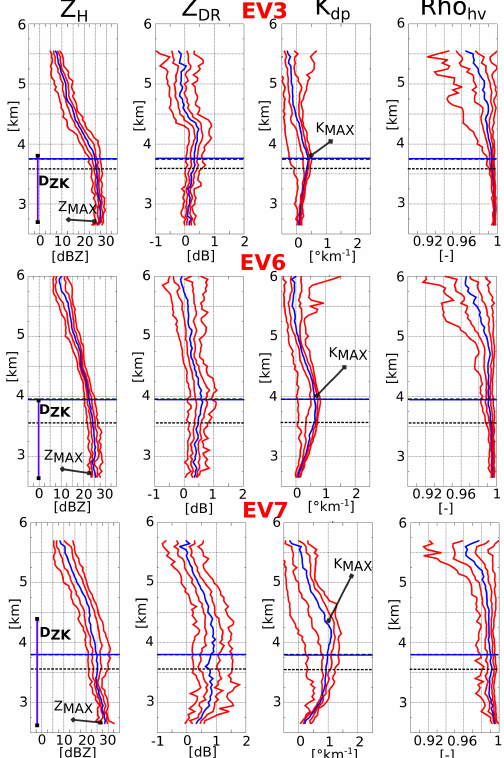
Figure 6. Vertical structure of polarimetric radar observations ex- tracted from a single RHI of each selected case. The blue horizon- tal line indicates the estimated altitude of the − 15 ◦ C temperature level, extrapolated from in situ measurements collected at the JFJ location by means of a lapse rate with altitude of − 6.5 ◦ km − 1 . The dashed black line indicates the altitude of JFJ. The polarimetric vari- ables are extracted considering a maximum elevation angle of 45 ◦ (the effect of incidence is corrected with the method of Ryzhkov et al., 2005). The red curves indicate quantiles at 5, 25, 75 and 95%, while the blue curve indicates the median. EV3 shows RHI data collected on 1 February 2014, 23:00UTC. EV6 shows data col- lected on 7 February 2014, 10:05UTC. EV7 shows data collected on 8 February 2014,